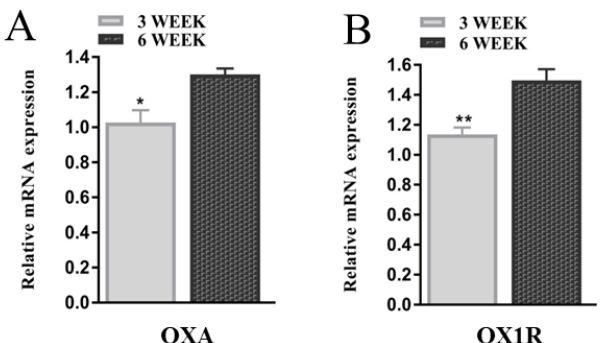
Figure 1. The expression of OXA and OX1R during different developmental stages of mouse GCs. ( A , B ) GCs of 3 week and 6 week-old female mice were cultured for 48 h, and total RNA was extracted. The mRNA expression of OXA and OX1R in mouse GCs of three- and six-week-old mice were detected using RT-qPCR. The expression values were normalized against β -actin and shown as the means ± SEM; * p < 0.05 and ** p < 0.01; GCs, granulosa cells; OXA, orexin-A; OX1R, orexin receptor type 1. 3.2. The Expression of OX1R was Efficiently Knocked down by Short Interfering RNA (siRNA) in Mouse GCs